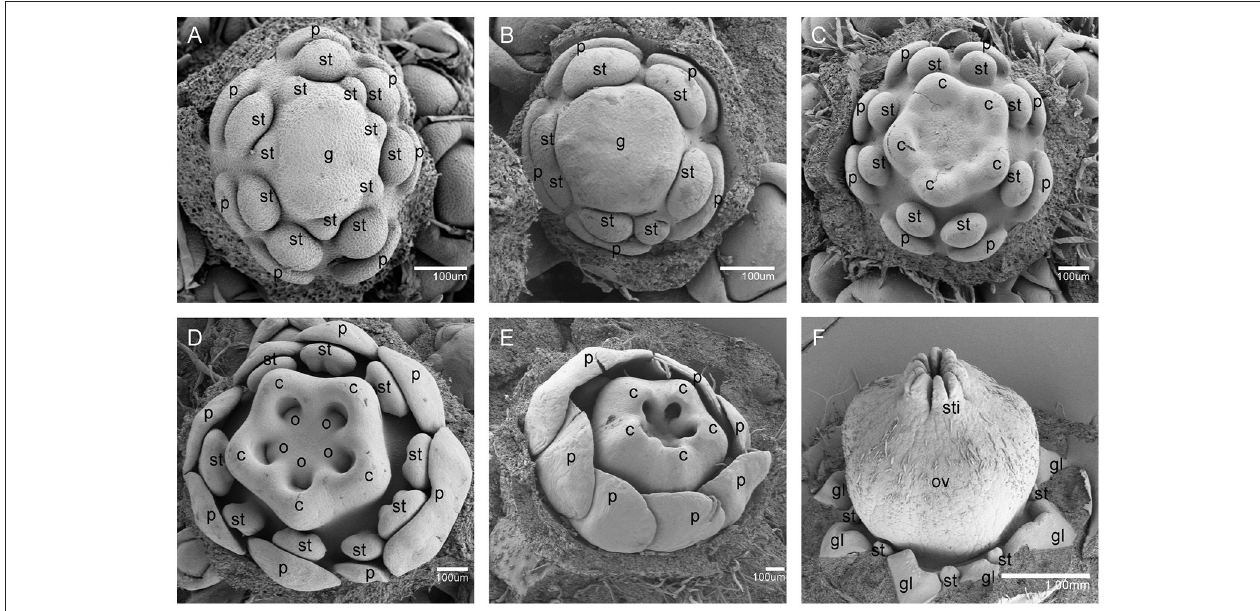
FIGURE 4 | The development of the female V. fordii flower during sex differentiation. (A) Stage 7 in the female flower: the floral meristem began to bulge and differentiate and the hemispherical gynoecium was established. (B) Stage 8: the gynoecium primordium enlarged and formed a flattened and rounded protrusion. (C) Stage 9: the carpel primordia appeared at the edge of the gynoecium. (D) Stage 10: the ovule primordia emerged. (E) Stage 11: the carpels were fused at the base. (F) Stage 12: each carpel differentiated into a short style and two-split stigma appeared. p, petal; st, staminode; g, gynoecium; c, carpel; o, ovule; ov, ovary; sti, stigma; gl,